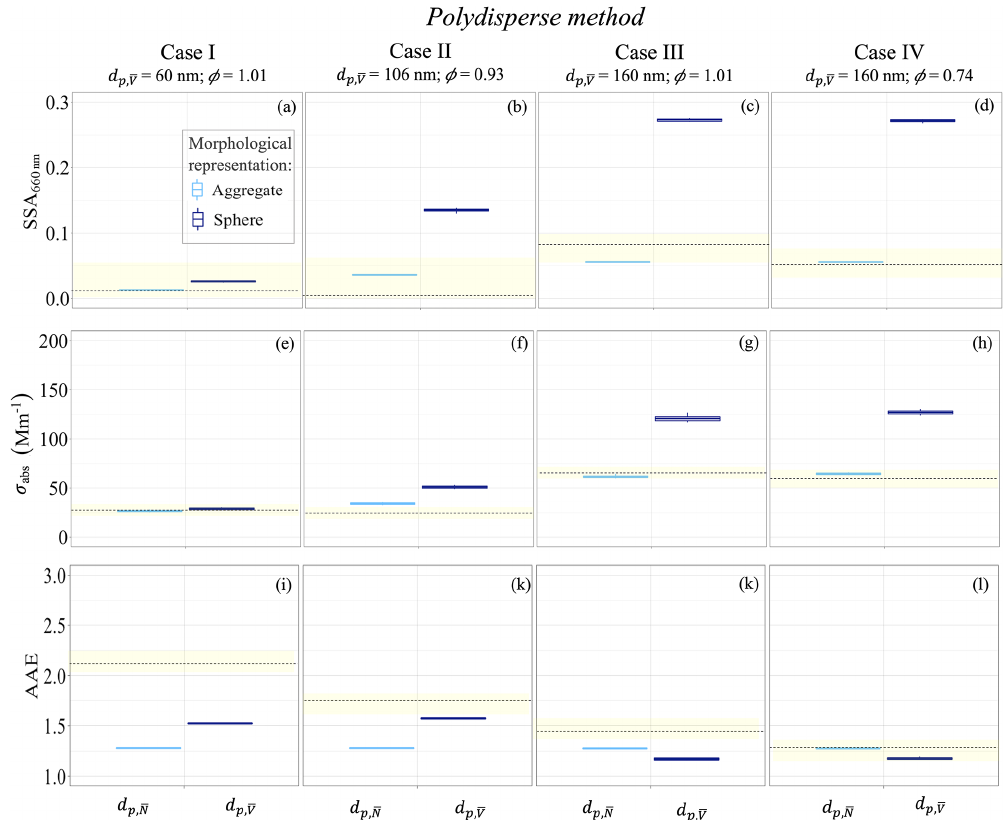
Figure 6. Optical properties of bare BC particles modelled using the polydisperse method compared to their measured values. Panels (a) – (d) show single-scattering albedo (SSA), and panels (e) – (h) show absorption coefficient ( σ abs ) for cases I–IV of E1. In each panel or case, the “sphere” and “aggregate” representations for bare BC particles were used, as shown in the legend. The shaded yellow area represents the experimentally measured values, with the dashed line being the mean of the measured SSA or σ abs